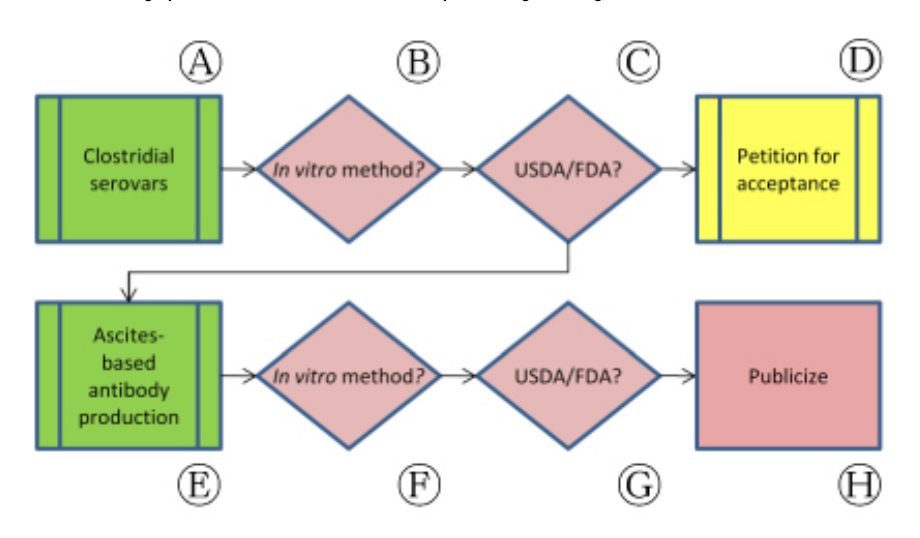
Figure 4. Application of bridging paradigm to clostridial vaccine potency testing and monoclonal antibody production for in vitro potency assays in the United